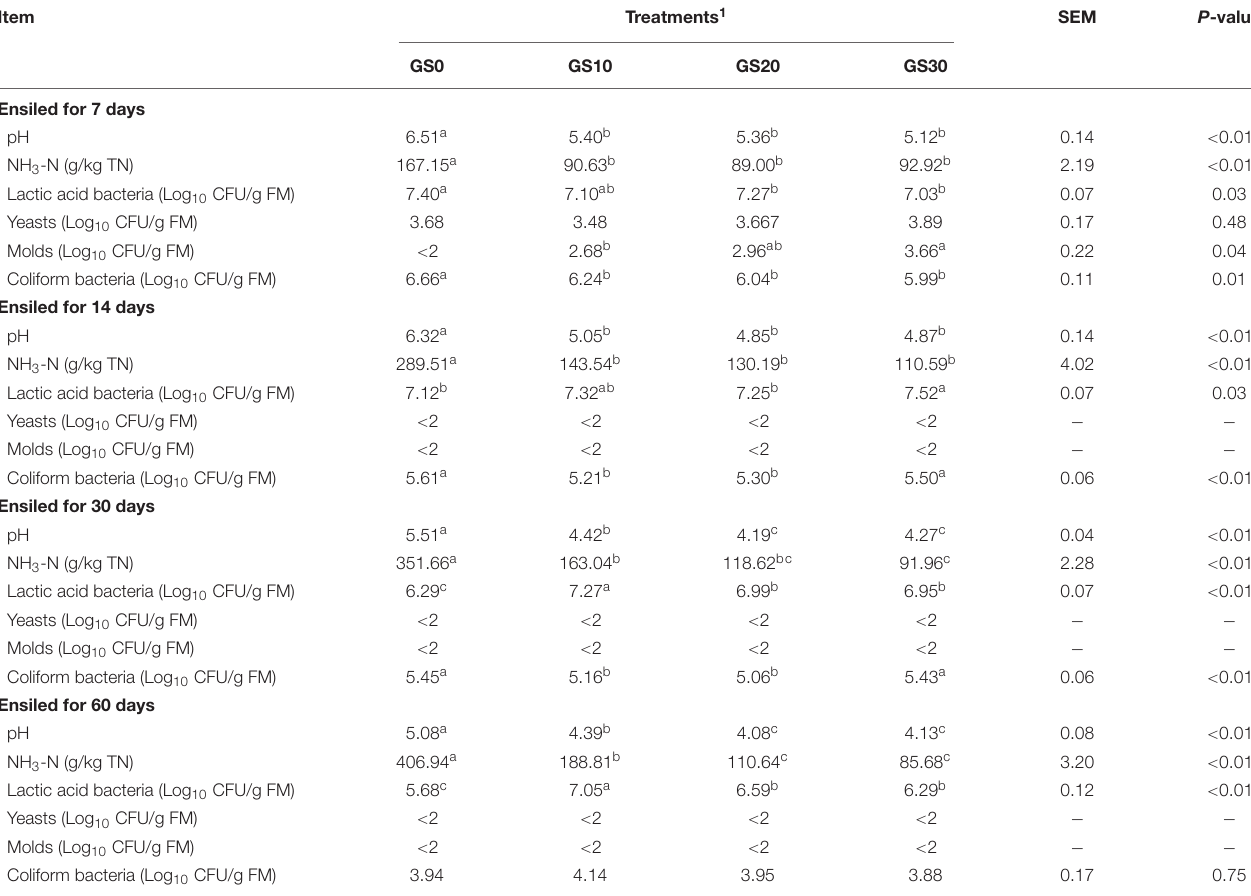
Item Treatments 1